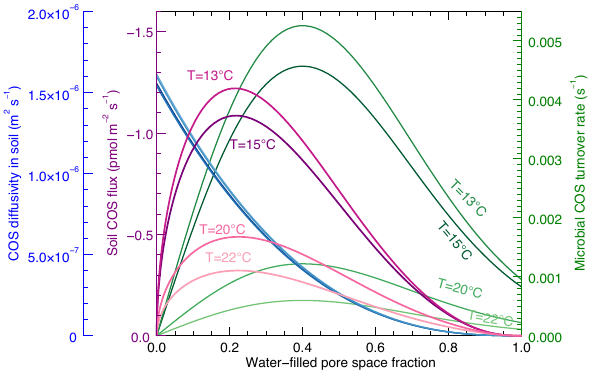
Figure 9. Modeled sensitivity of surface soil COS uptake to water- filled pore space fraction (purple) at soil temperatures of 13, 15, 20 and 22 ◦ C, ambient COS mixing ratio of 500pmolmol − 1 , and V SU , max = 10 − 2 molm − 3 s − 1 as in Eq. (21). Soil porosity is set at 0.35m 3 m − 3 , and T opt is about 13 ◦ C. Only soil COS uptake activ- ity is included in these simulations. Also shown are the two model variables that dominate the simulated flux response, the effective soil COS diffusivities (blue) and microbial COS uptake turnover rates (green) at the same soil temperatures. Note the y axis of soil COS flux is reversed to show the uptake.